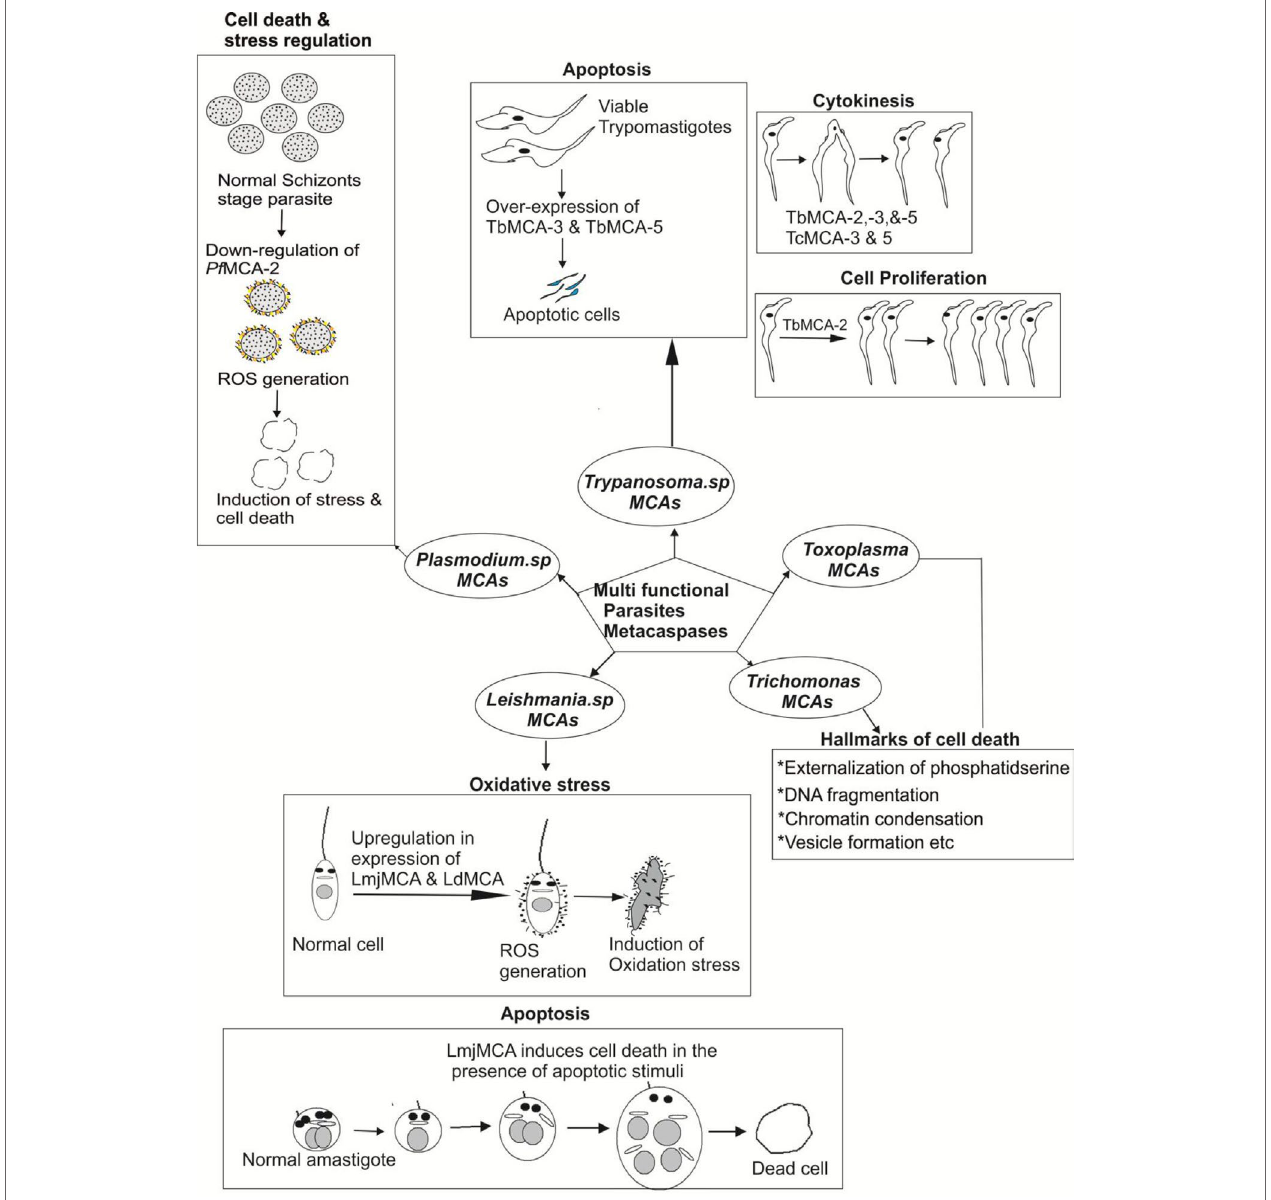
FIGURE 5 | Pictorial depiction for multi-functions of metacaspases in different parasites: Trypanosoma metacaspases are found to play versatile function such as apoptosis, cell proliferation, cytokinesis of the parasites (Meslin et al., 2011; Proto et al., 2011); Leishmania metacaspases are involved in stress regulation and autophagy of the parasite (Khademvatan et al., 2011; Casanova et al., 2015; Peña et al., 2017); Plasmodium metacaspases also play a role in apoptosis and stress regulation of the parasites (Vandana et al.,